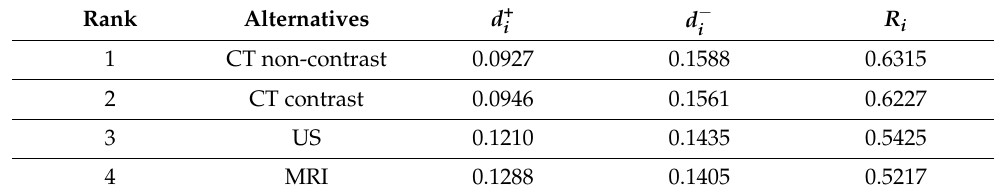
Table 4. Ranking of the acute appendicitis diagnosis for low AIR score by F-TOPSIS approach.